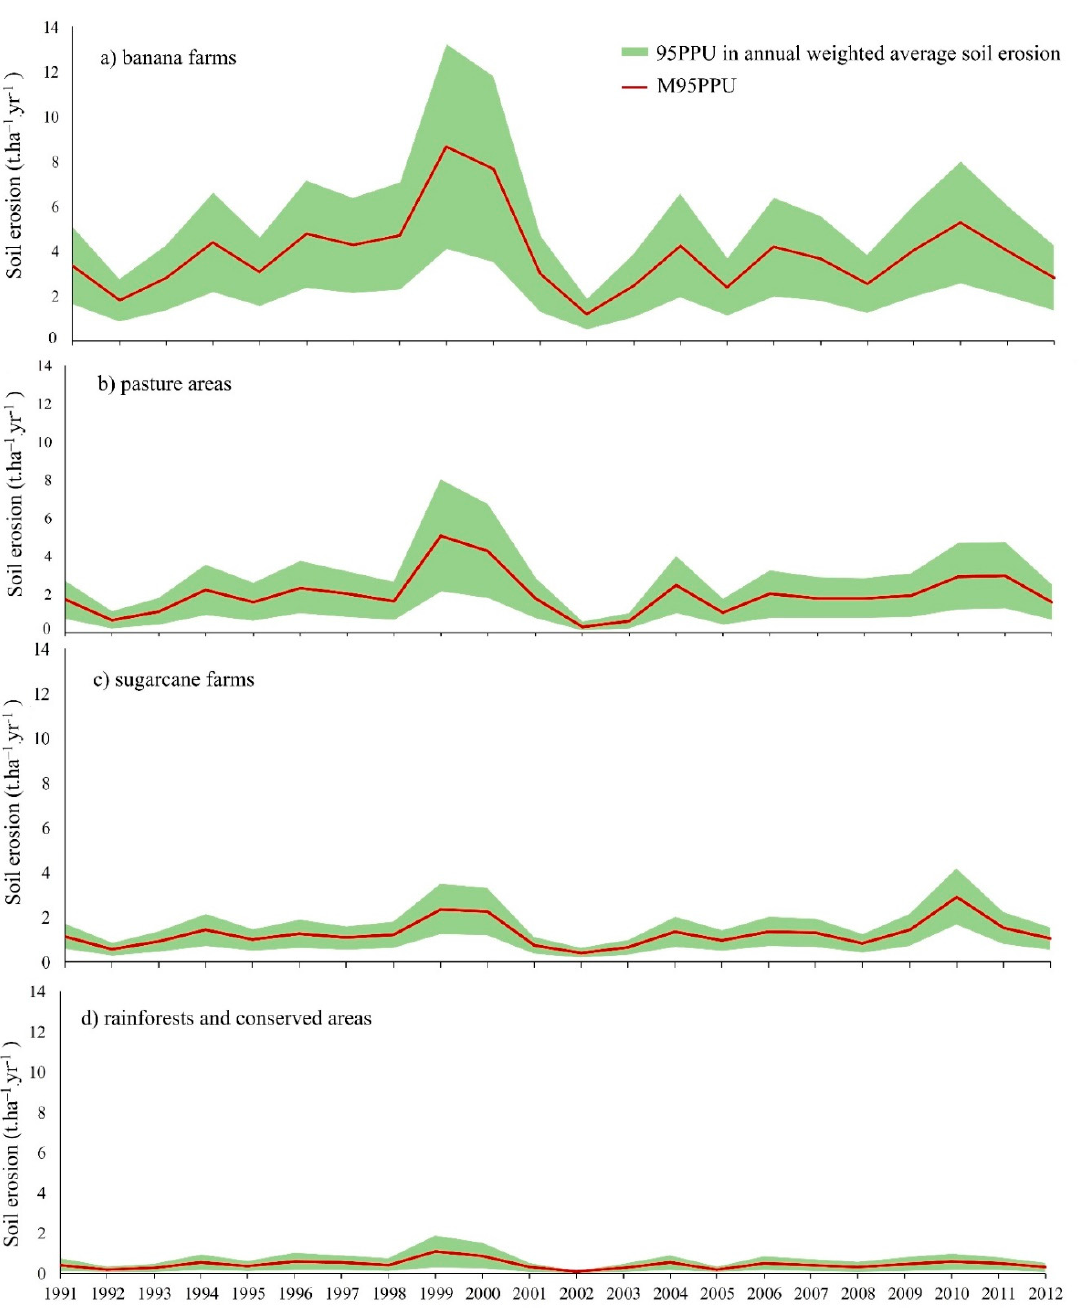
Figure 10. The 95PPU and average of 95PPU (M95PPU) of soil erosion in ( a ) banana farms, ( b ) pasture HRUs, ( c ) sugarcane HRUs, and ( d ) rainforests HRUs where 95PPU here represents the annual weighted average of soil erosion among the HRUs with the same land use based on their total land use area.